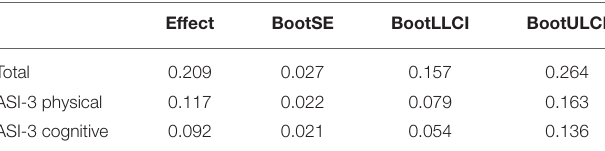
TABLE 4 | Analysis of the mediating effect of physical concern and cognitive concern on negative bias affecting anxiety.